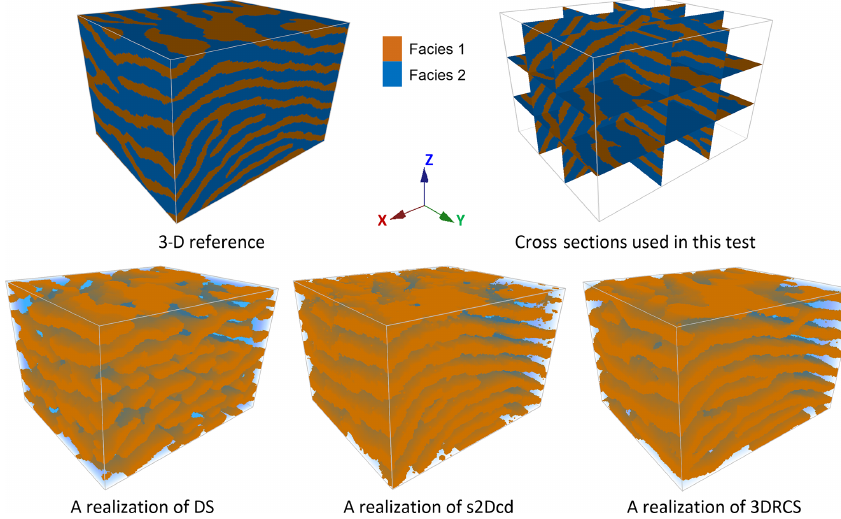
Figure 9. Realizations of three different MPS reconstruction methods.